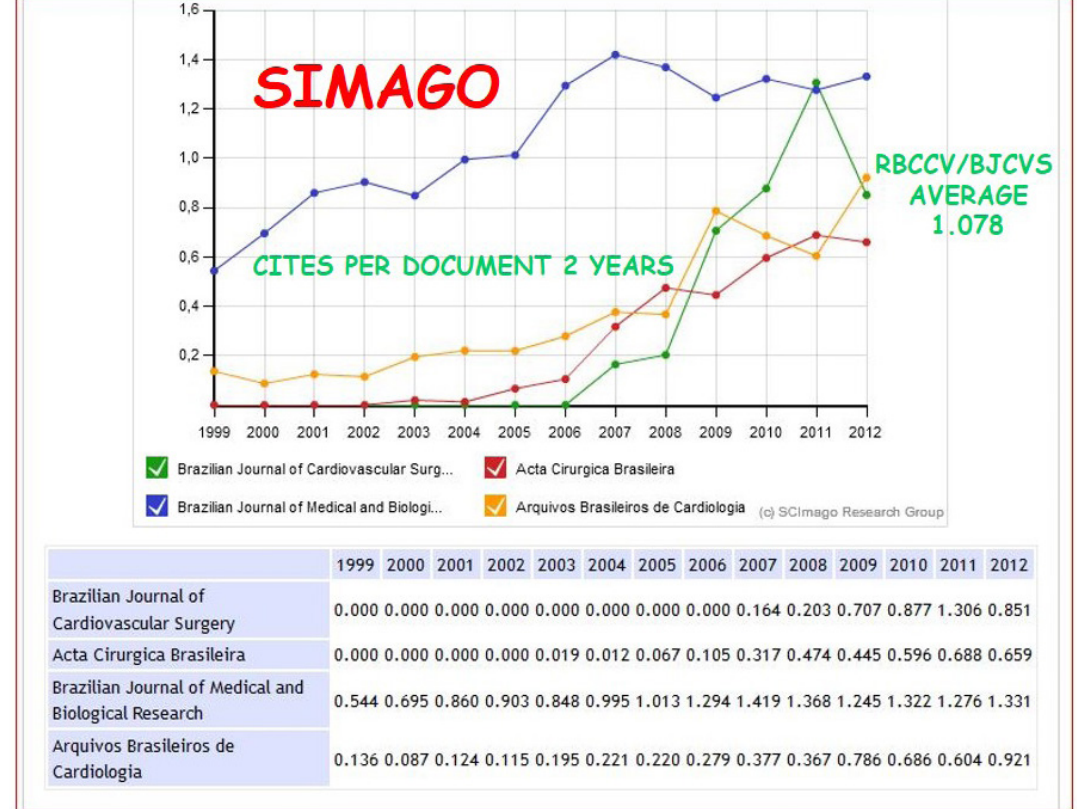
Fig. 1 - Chart showing the evolution of BJCVS, Acta Cirúrgica Brasileira, Arquivos Brasileiros de Cardiologia and Brazilian Journal of Medical and Biological Research in